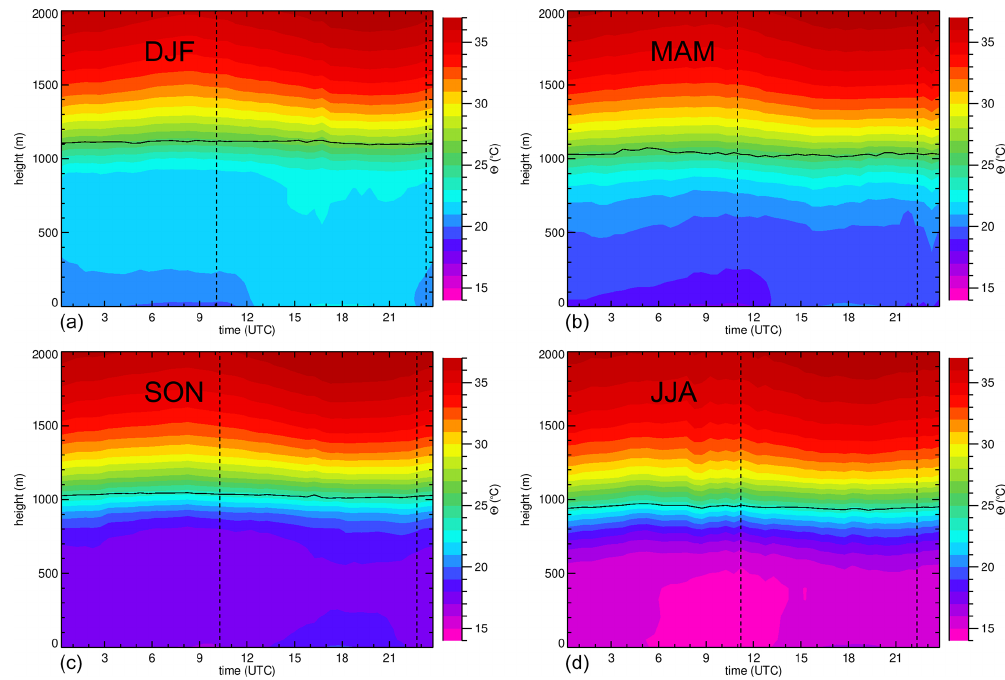
Figure 4. Mean potential temperature during different seasons as a function of time of day and height. Clockwise: (a) austral summer (DJF), (b) fall (MAM), (d) winter (JJA) and (c) spring (SON). Color shading is based on 3-month averages of 1h and 30m intervals. Black line depicts the average height of the strongest gradient. Vertical dashed lines indicate average times of sunrise and sunset. The analysis here is restricted to the same days as the Cloudnet